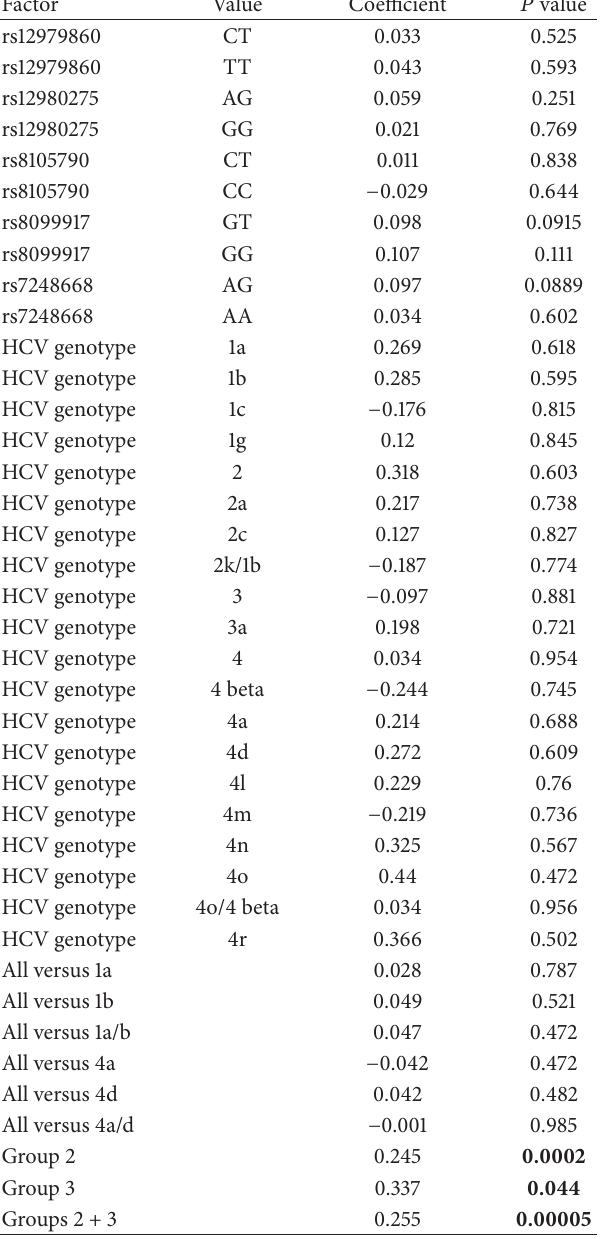
Table 5: Correlation of average IL28B serum levels with the geno- types of rs8099917.